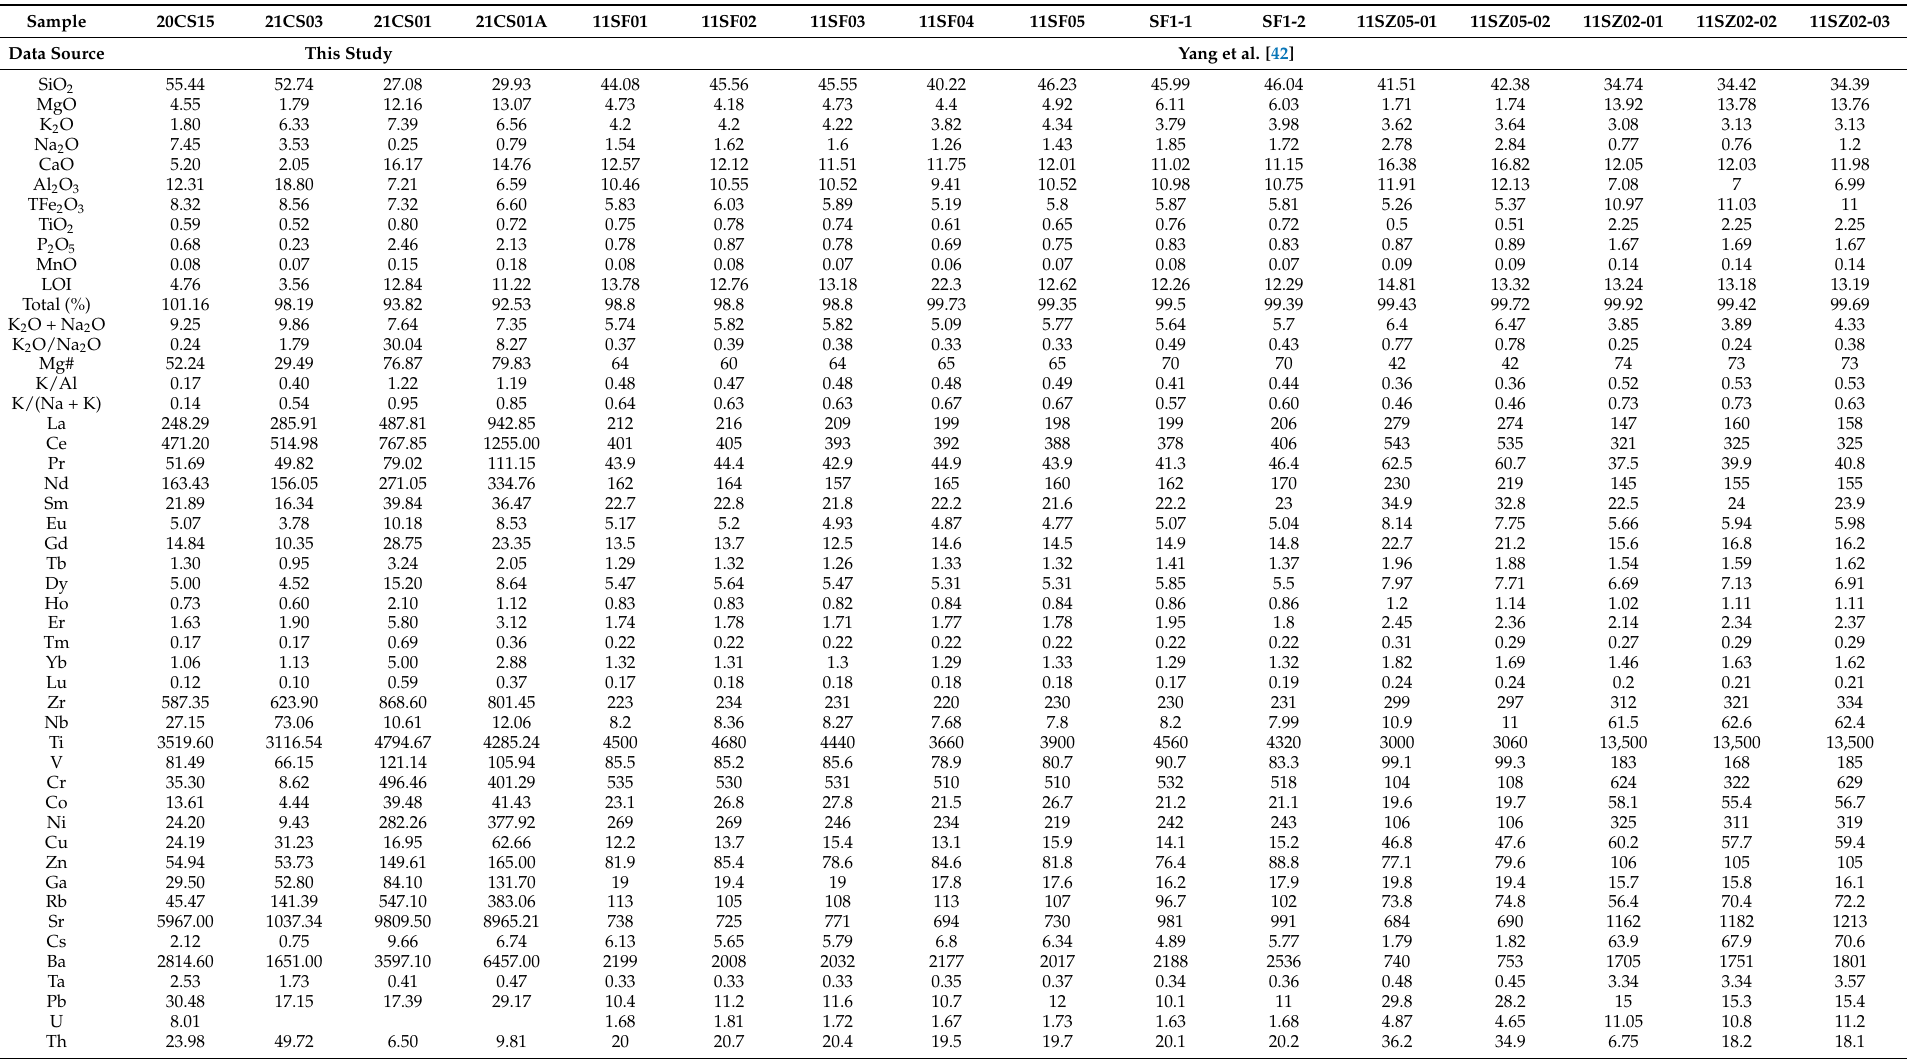
Table 1. Major, trace and rare earth element (REE) compositions for the